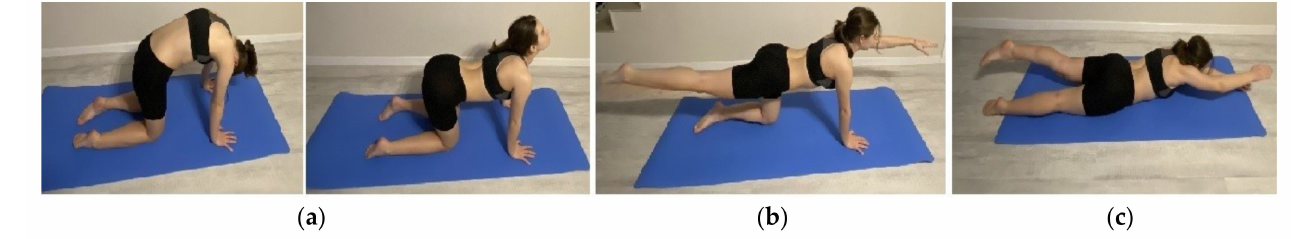
side simultaneously with the leg on the opposite side, alternatively; ( c ) the supermen